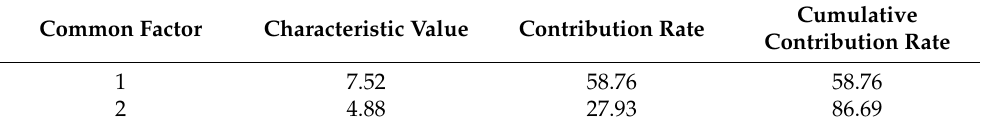
Table 5. Factor analysis